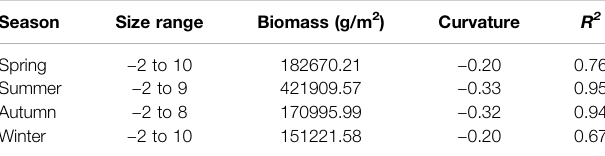
TABLE2| Seasonalcomparisonofthenormalizedbiomassparticlesizespectrum of fi sh in Daya Bay.